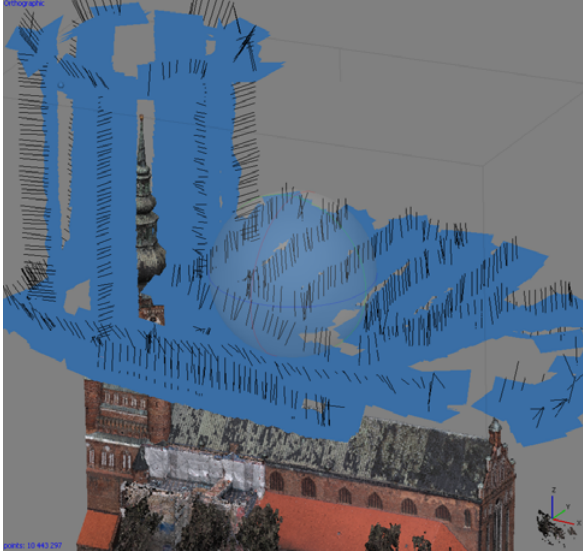
Figure 5. Photogrammetric block configuration of the cathedral